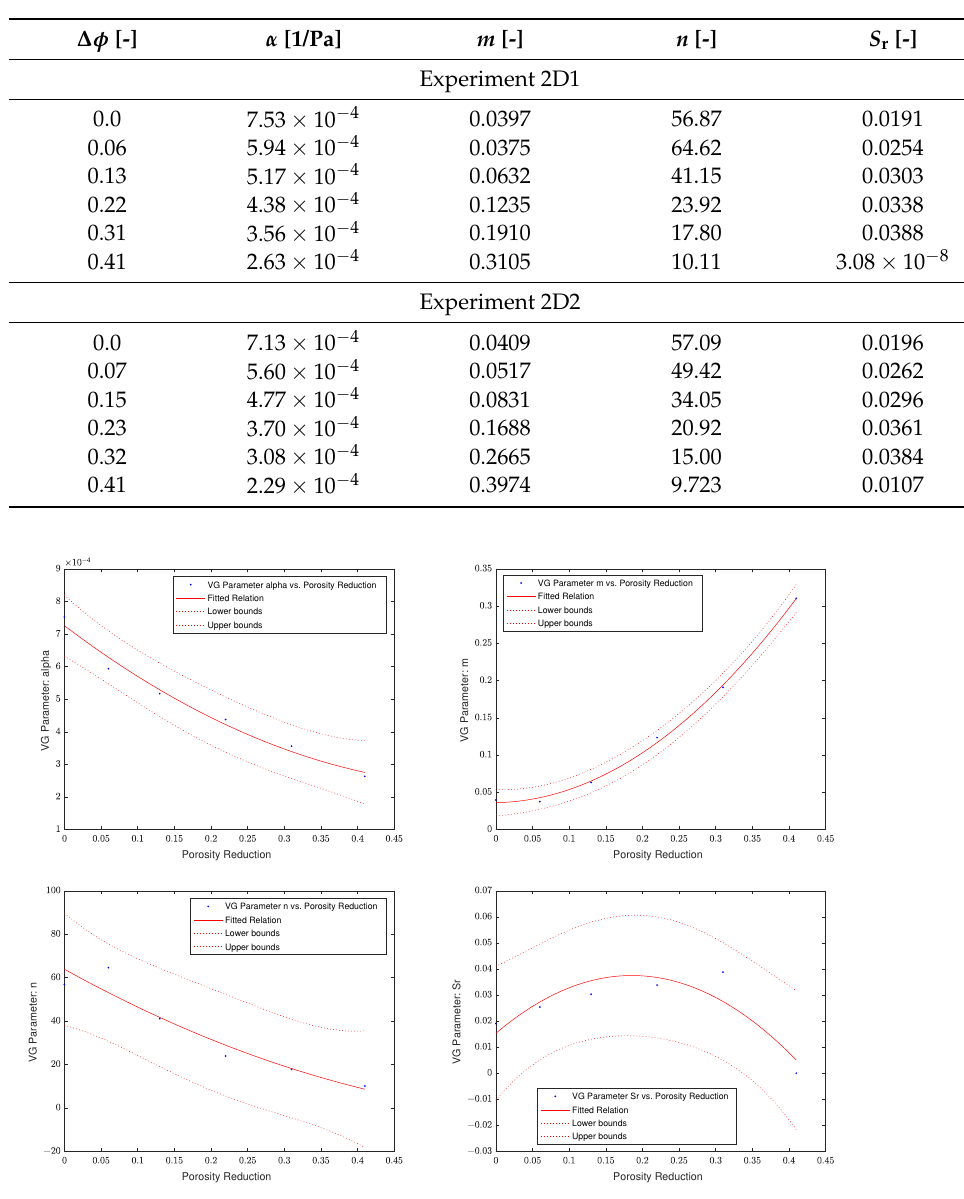
Table 2. Parameters of the Van Genuchten capillary pressure–saturation relation (Equation (5)) for various porosity reductions ∆ φ due to EICP.